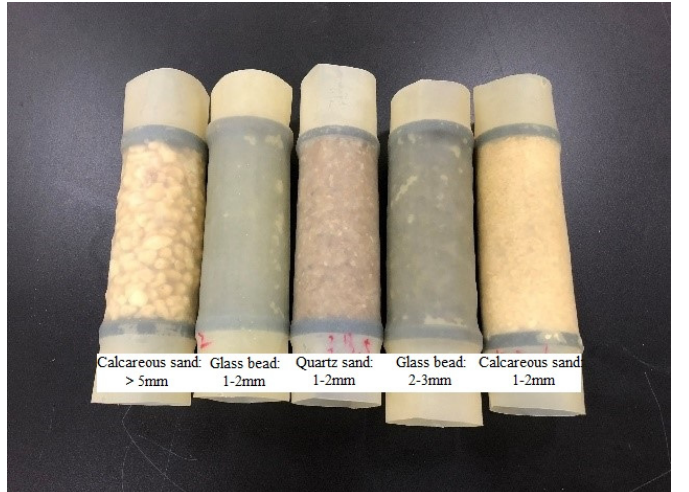
Figure 4. Photograph of the tested specimens. Table 1. Test program of this study.